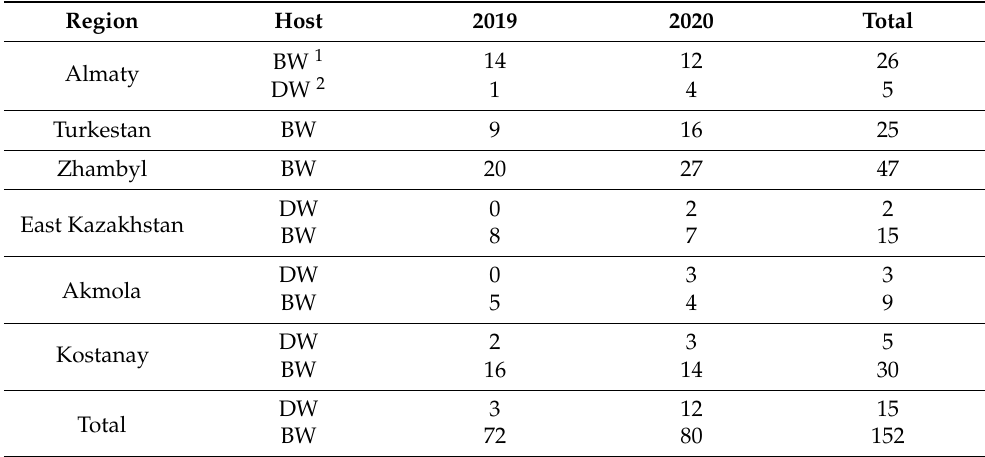
Table 2. The number of Pyrenophora tritici-repentis isolates recovered and characterized in 2019 and 2020 in six regions of Kazakhstan. Region